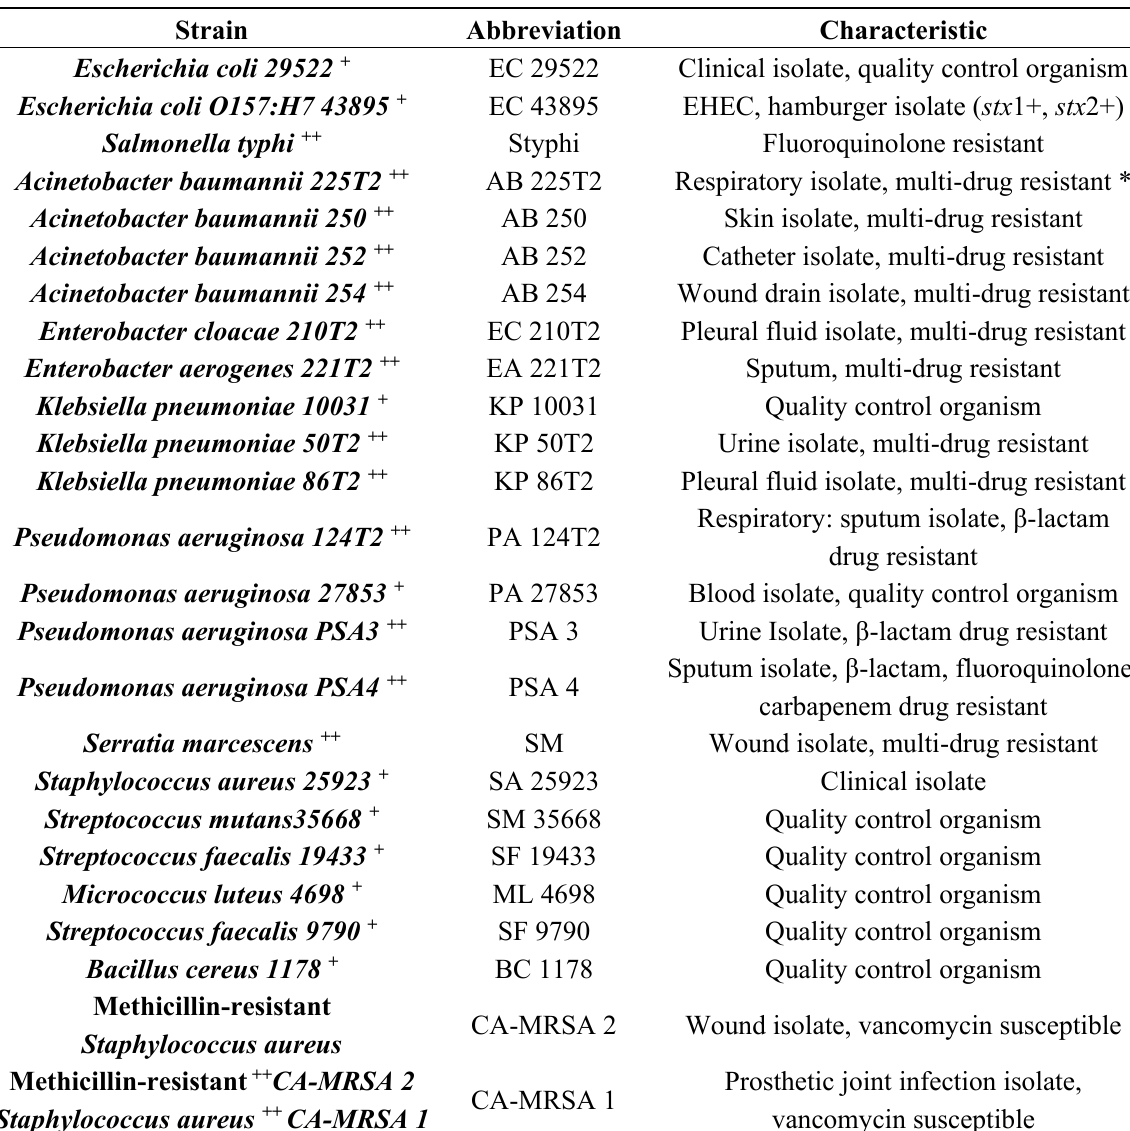
Table 1. Drug-susceptible and drug-resistant bacterial